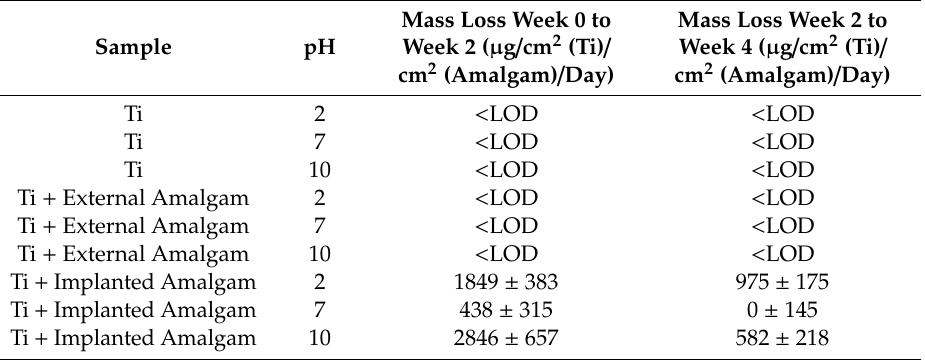
Table 2. Mass loss of the Ti rods without amalgam, Ti rods with external amalgam, and implanted amalgam after 2 weeks and 4 weeks of soaking in a buffer solution at 37 °C. (Note: <LOD = a mass measurement below the limit of detection of the scale used.)